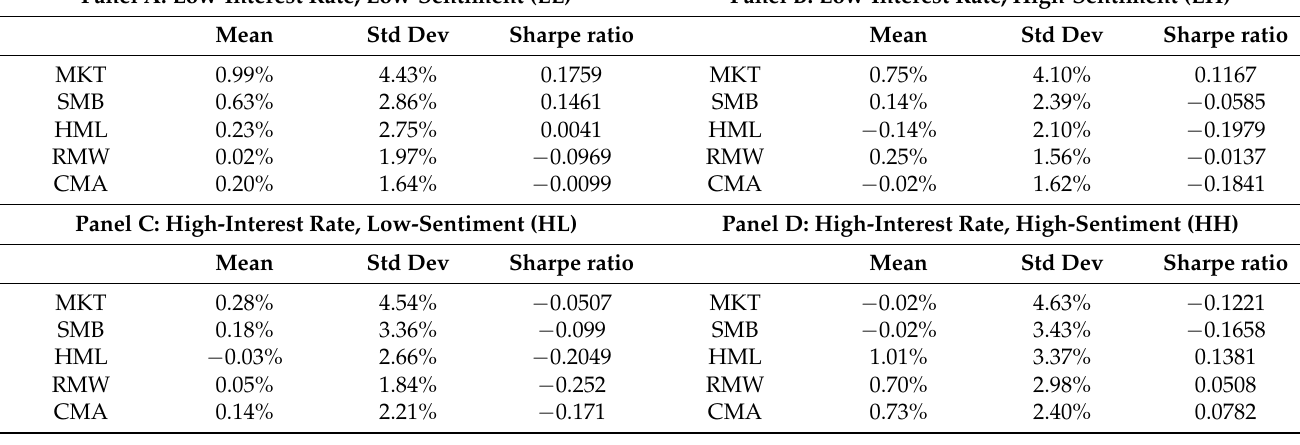
Table 6. Five-factor returns and Sharpe ratio in market cycles. The sample period spans from July 1965 to December 2018; 642 monthly observations: LL (186), LH (135), HL (139), HH (181). All values and percentages in the table are monthly data (not